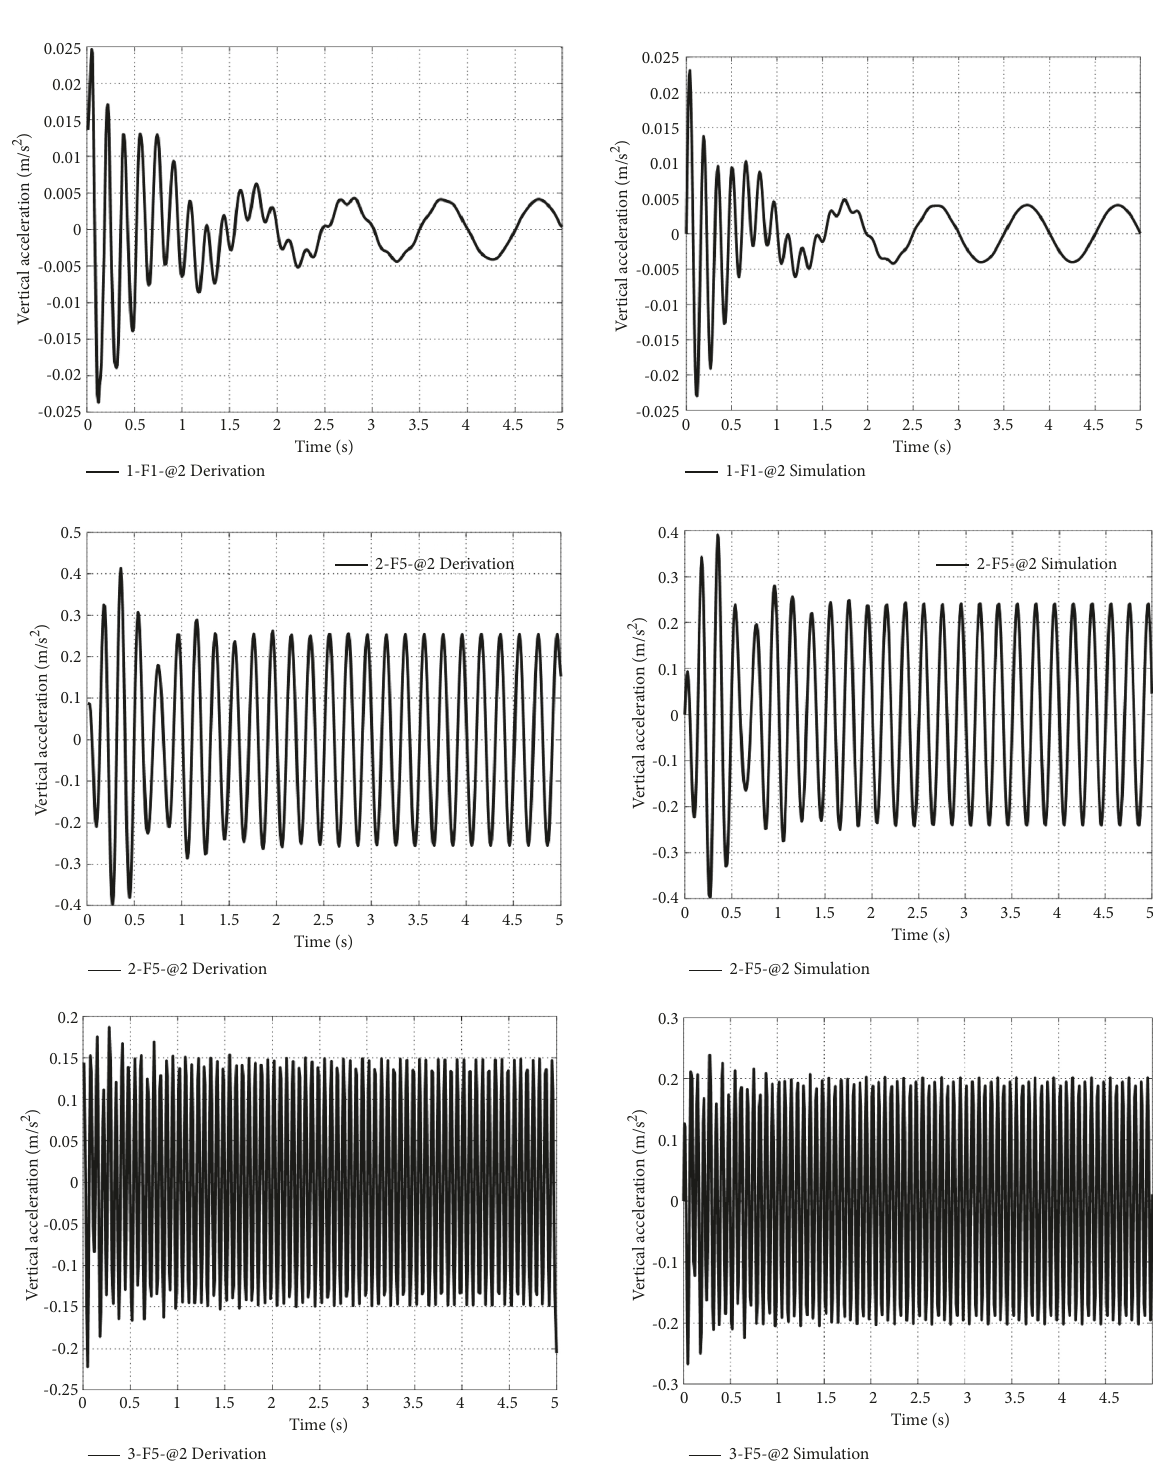
Figure 7: Comparison of theoretical derivation and numerical analysis of vibration point under multi-point